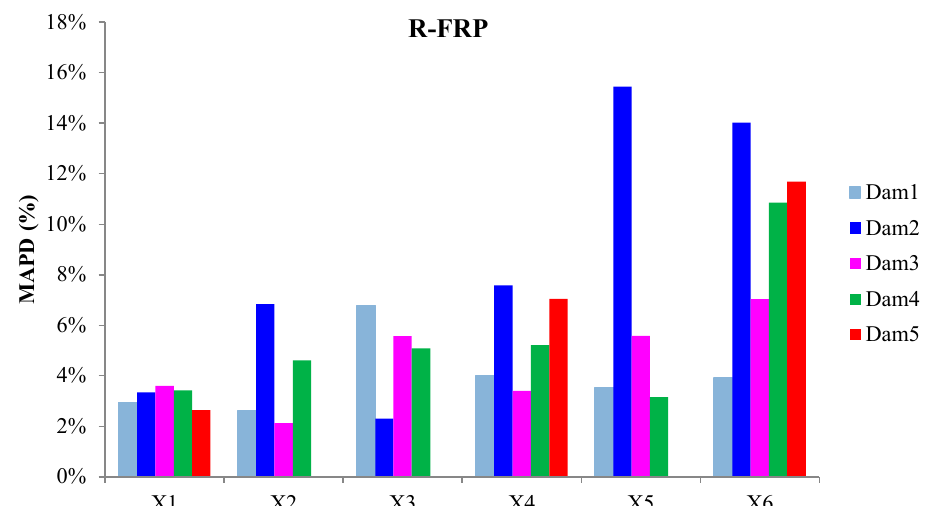
Figure 17. RMSD index values of PTZs externally epoxy-bonded on the surface of R-FRP.